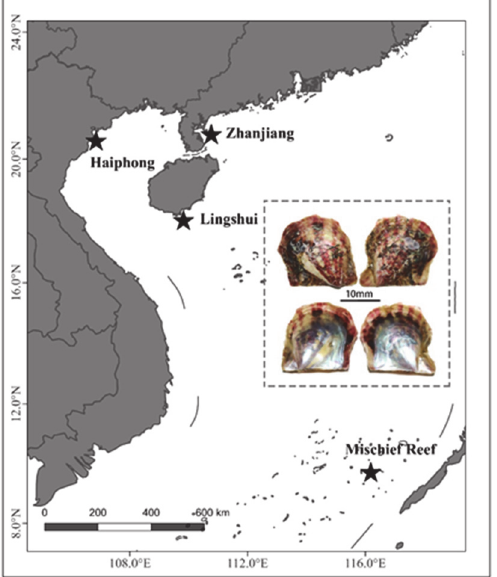
Figure 1. The sample sites in the present study. Stars represent the sampling sites.